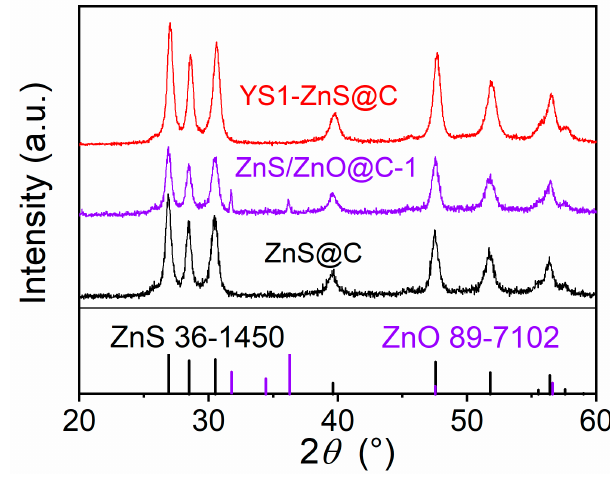
Figure 2. XRD patterns of ZnS@C, ZnS/ZnO@C-1 and YS1-ZnS@C.